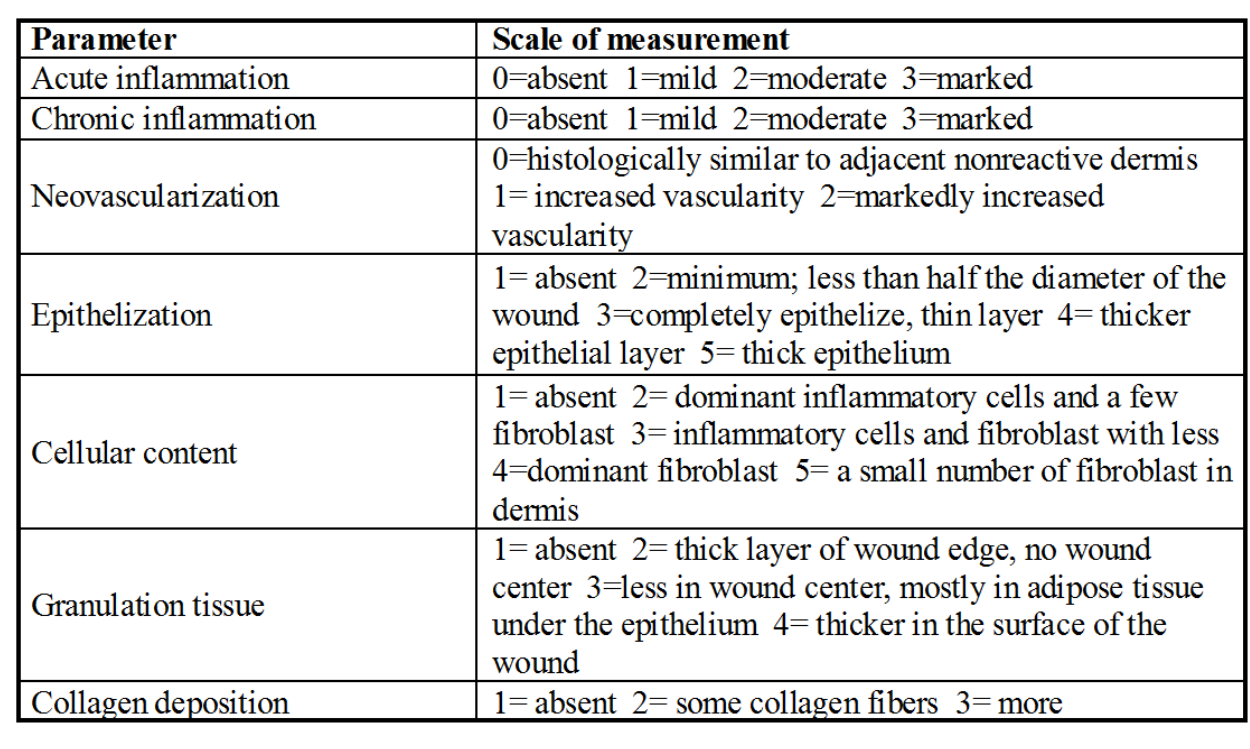
TABLE I - H istopathologic parameters used to evaluate the effect of chitosan and pGM-CSF on rat wound healing (Lasa et al. (1993) and Kirchner et al. (2003))